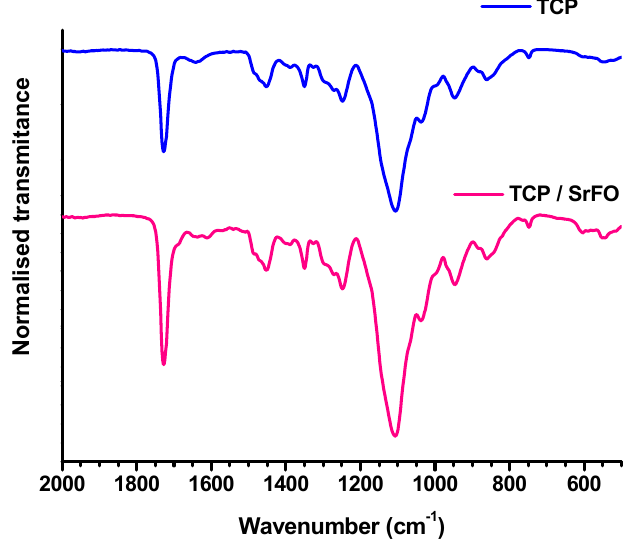
Figure 7. Surface analysis by FTIR-ATR spectroscopy of TCP and TCP/Sr scaffolds. Figure adapted from Martín-del-Campo et al. [16] with permission from the Royal society for Chemistry.